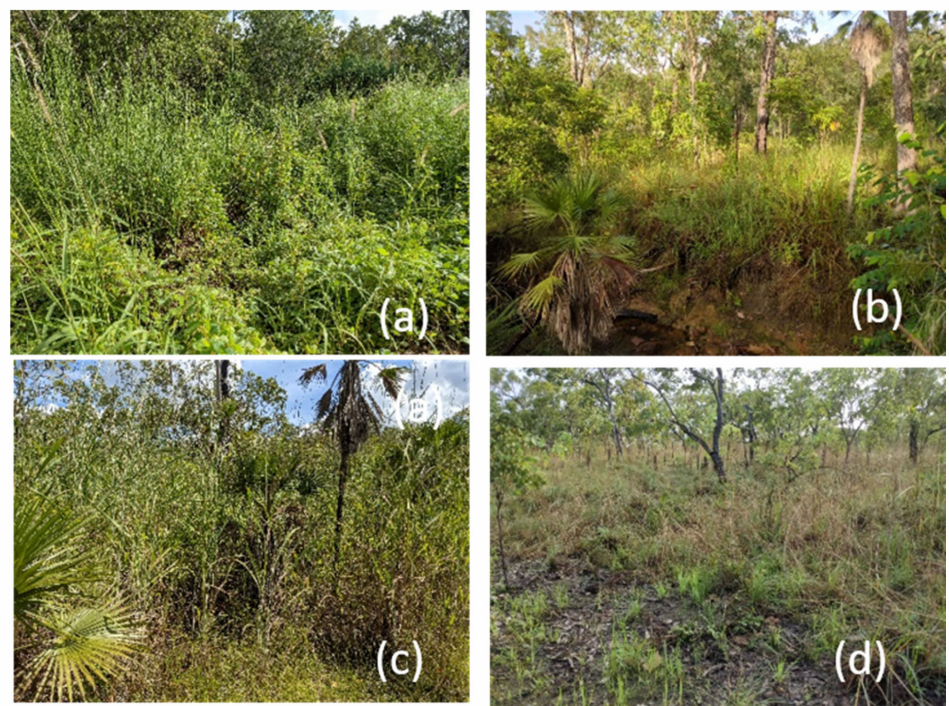
Figure 5. Landscape grazed by antilopine and common wallaroos infested by unpalatable species from a prior pastoral use. ( a ) Invasive annual ( Cenchrus pedicellatus ) and perennial ( Cenchrus polystra- chios ) mission grasses (and other herbaceous weeds) in a riparian zone, ( b ) Riparian grassland of native species, ( c ) Invasive gamba grass ( Andropogon gayanus ) amongst native sand palms, and ( d ) Grassy understory of native savanna woodland. (All images by